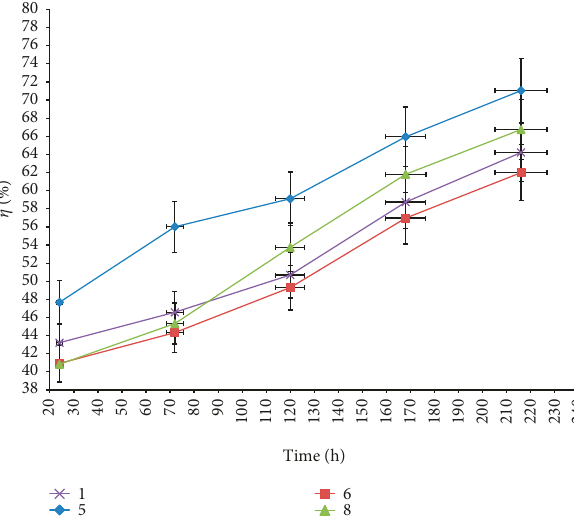
Figure 3: Relation between inhibition efficiency of aminopyridine derivatives in 6M HCl and time at room temperature at